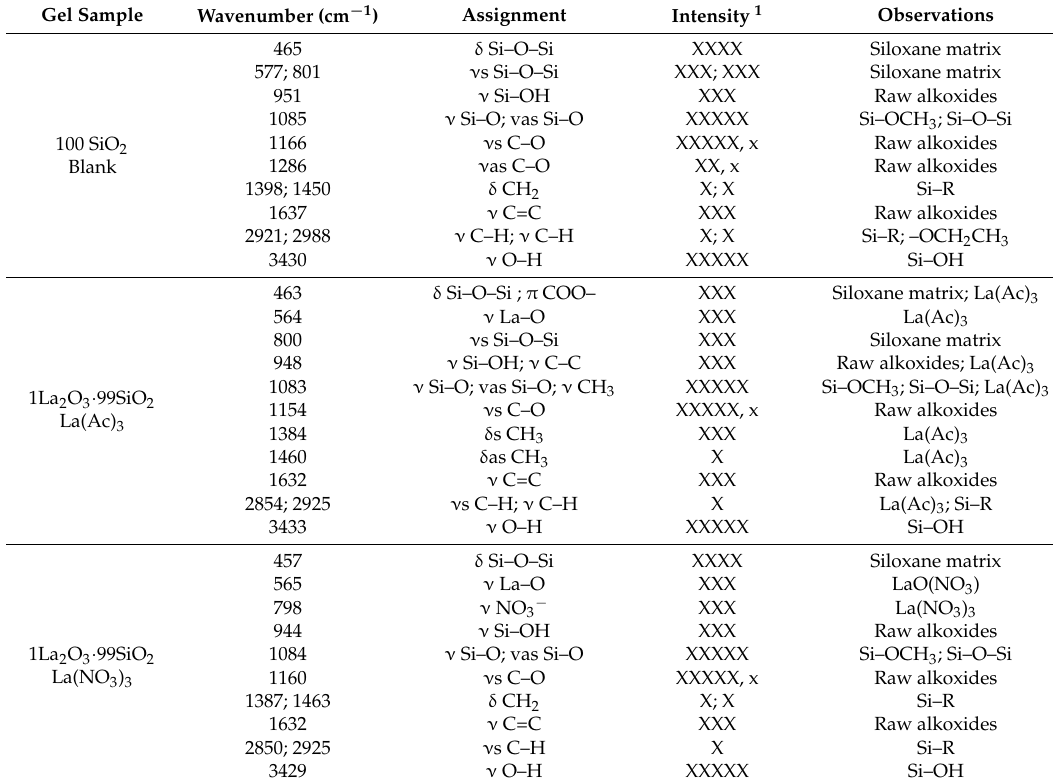
Table 8. FTIR assignments of some of the samples studied